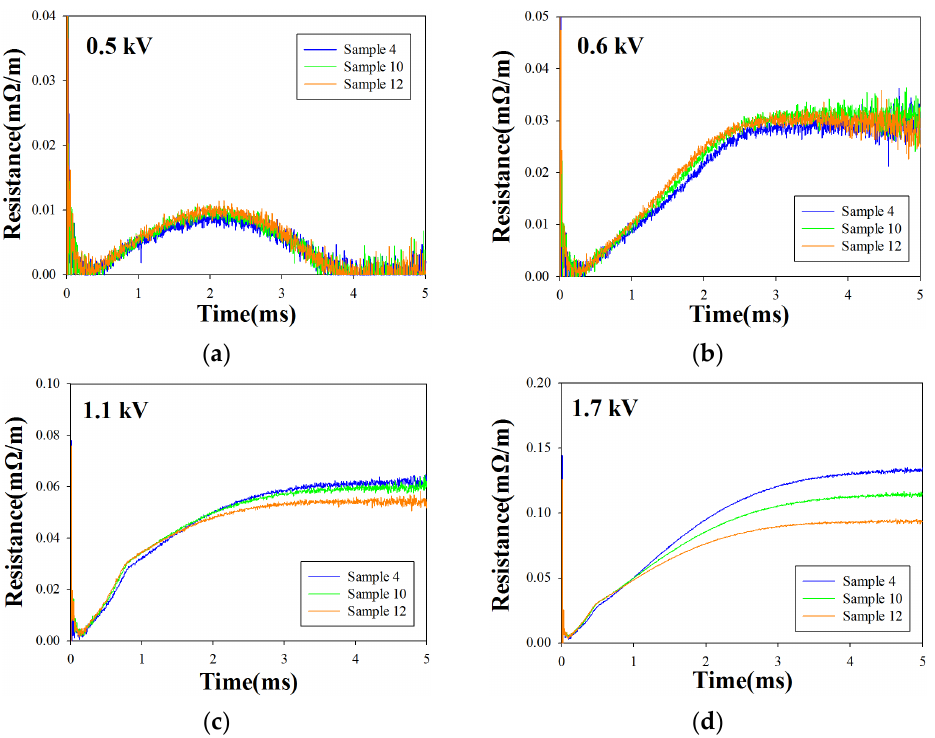
Figure 17. Impulse resistance response of samples 4, 10, and 12: ( a ) 0.5 kV impact; ( b ) 0.6 kV impact; ( c ) 1.1 kV impact; ( d ) 1.7 kV impact.